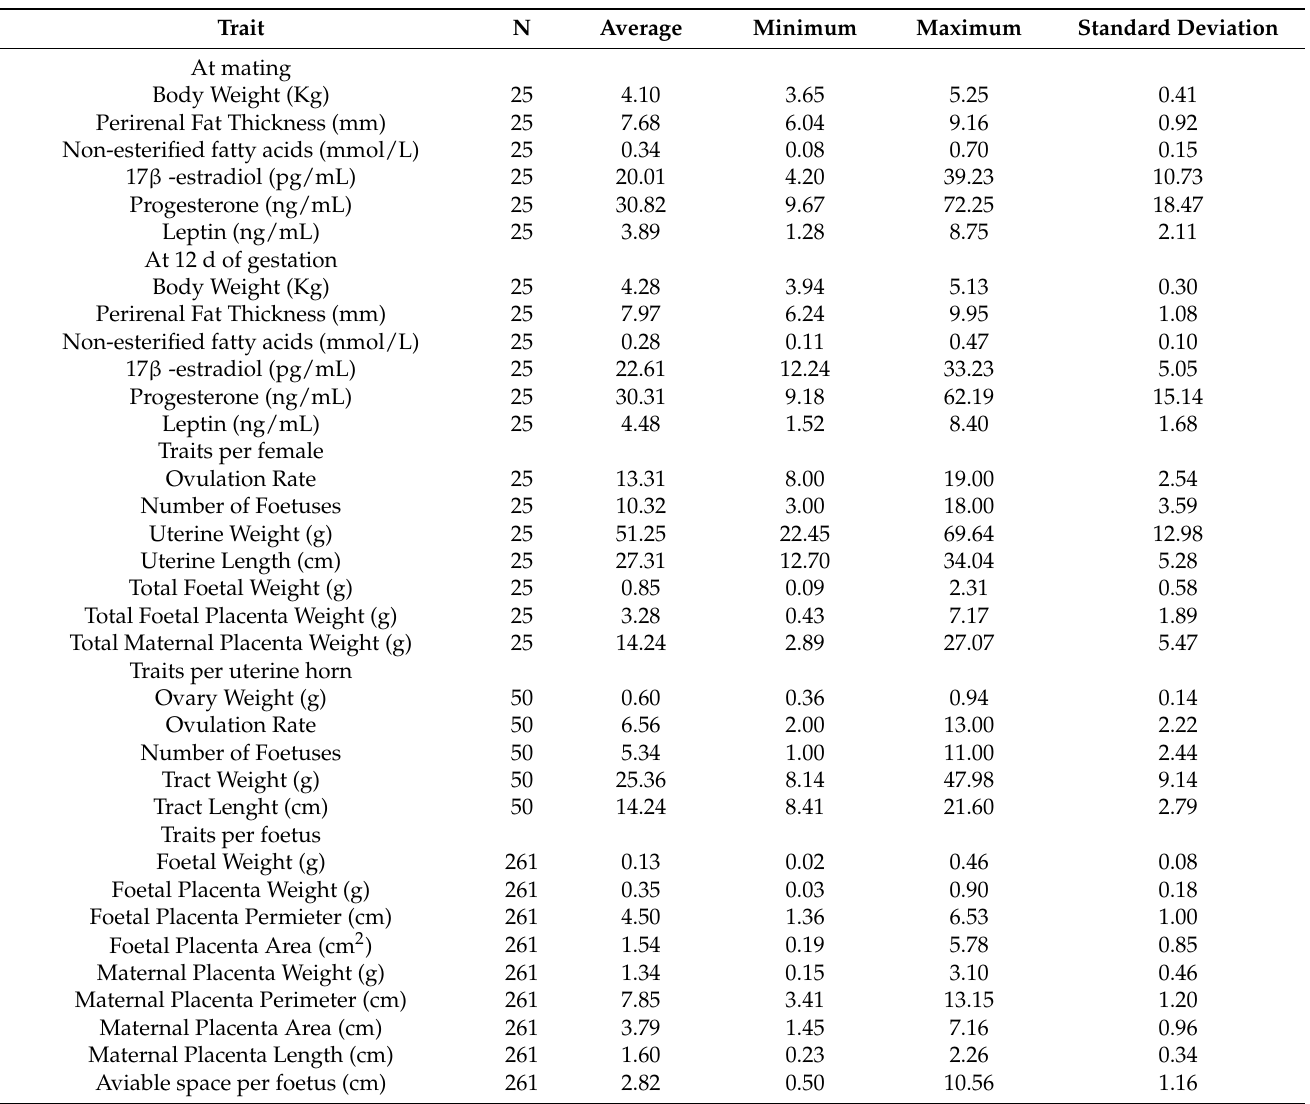
Table 1. Summary statistics of the traits.